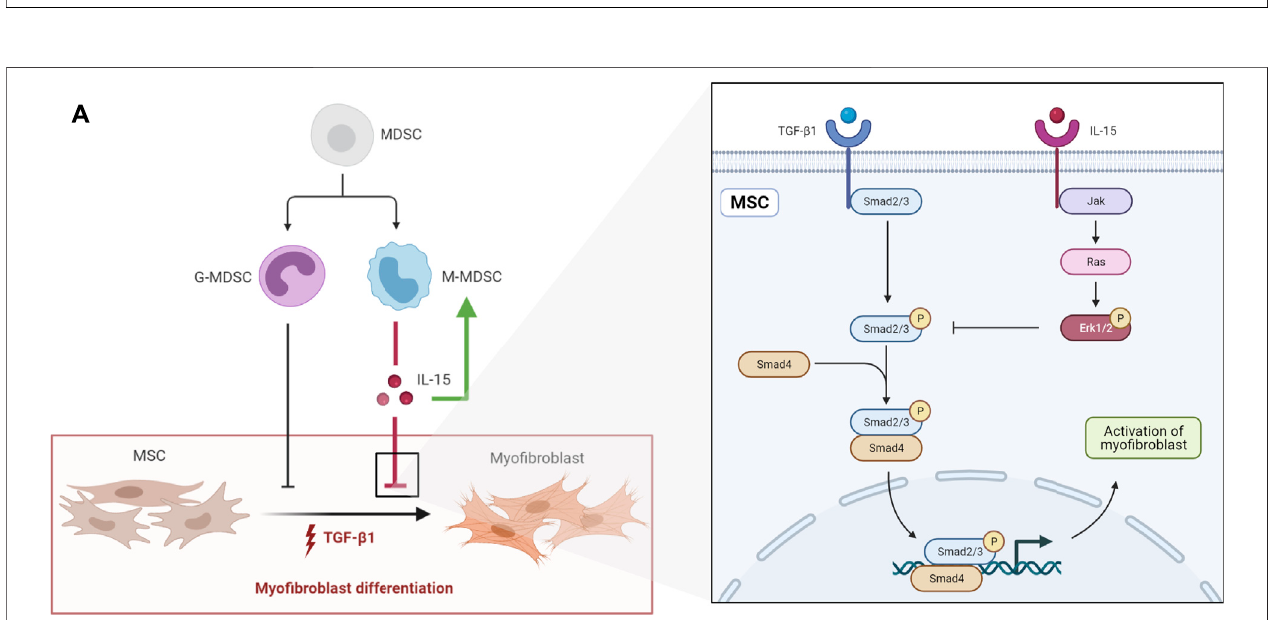
FIGURE 7 | The effects of M-MDSCs on the myo fi broblastic differentiation of renal resident MSCs are mediated by IL-15-Ras-Erk1/2-Smad2/3 signaling. (A) Immuno fl uorescence costaining of Sca-1/Ras, Sca-1/p-Erk1/2 and Sca-1/p-Smad3 in the kidney on Day 2 after the operation. Scale bar: 10 μ m * p < 0.05; ** p < 0.01; *** p < 0.001.